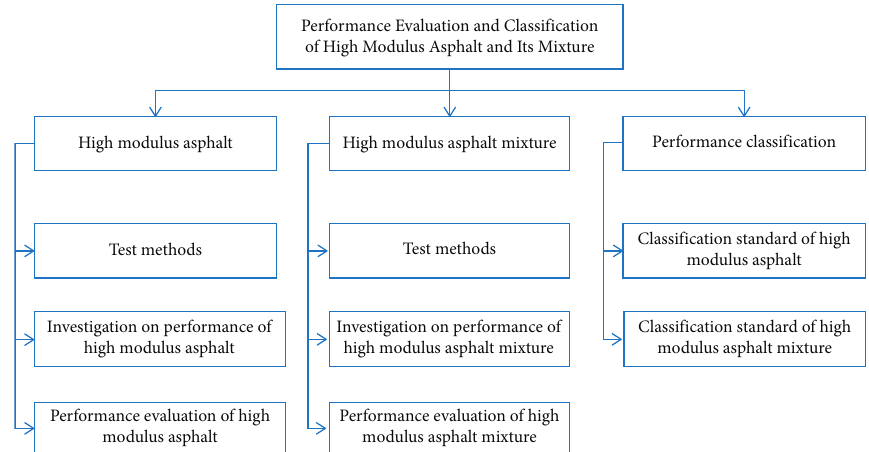
Figure 1: Flow chart of the overall